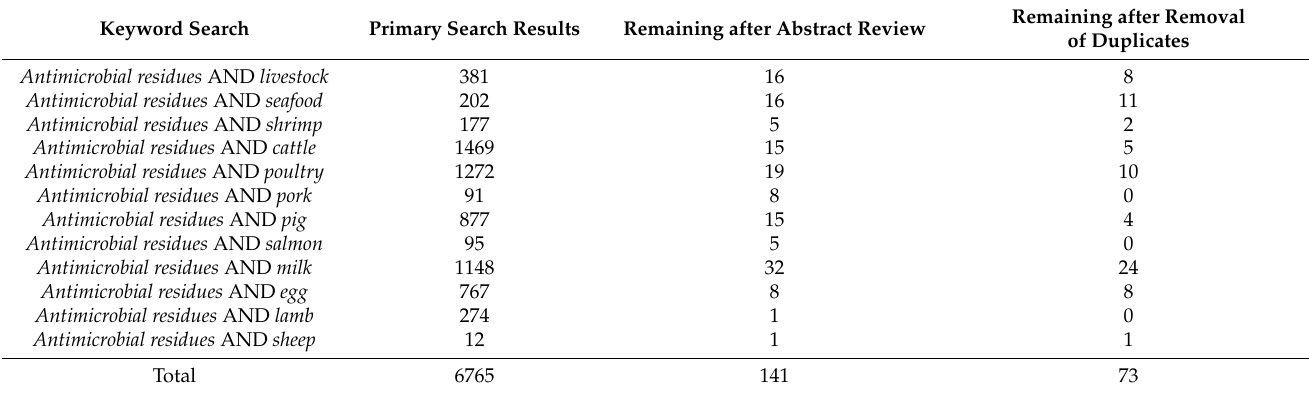
Table 1. Summary of the search results displayed in three steps.